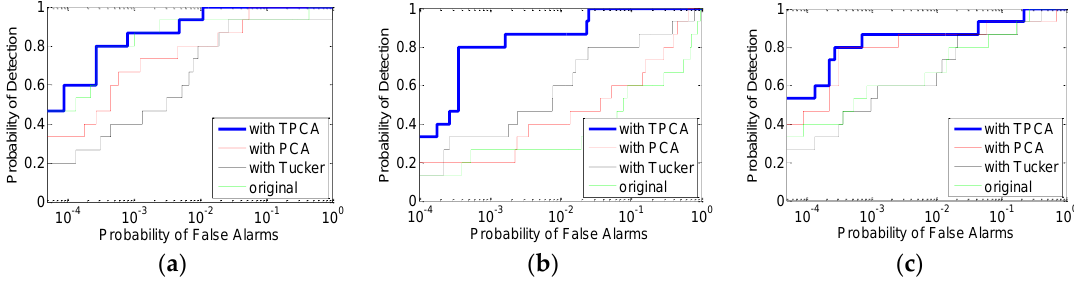
Figure 15. ROC curves with different feature extraction methods for Hyperion data: ( a ) CEM; ( b ) ACE; and ( c ) AMF.